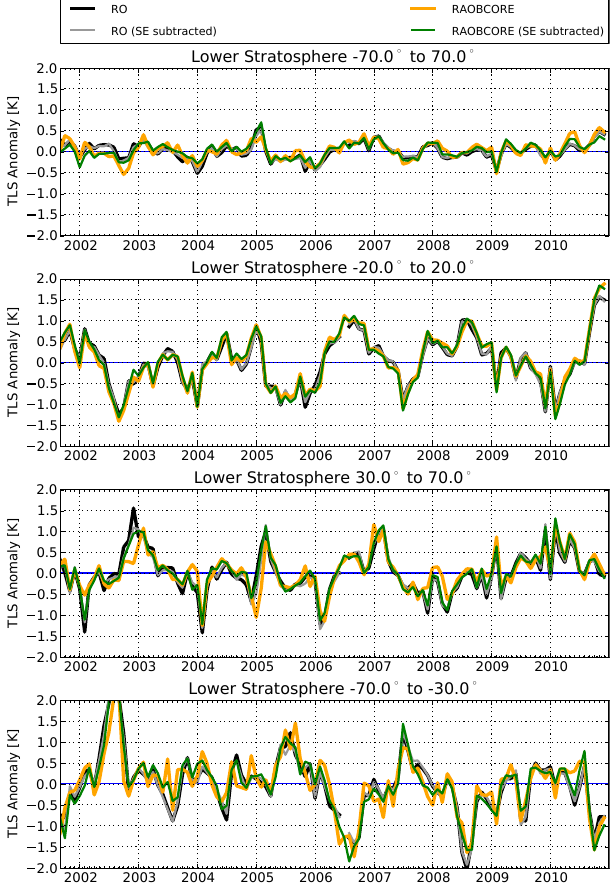
Table 2. Trends of anomaly differences for the period of Sep. 2001 to Dec. 2010. The ± value defines the 95% confidence intervals for the trends. Trend values which are significantly different from 0 at the 90% and 95% level are marked by a single and double asterisk, respectively.